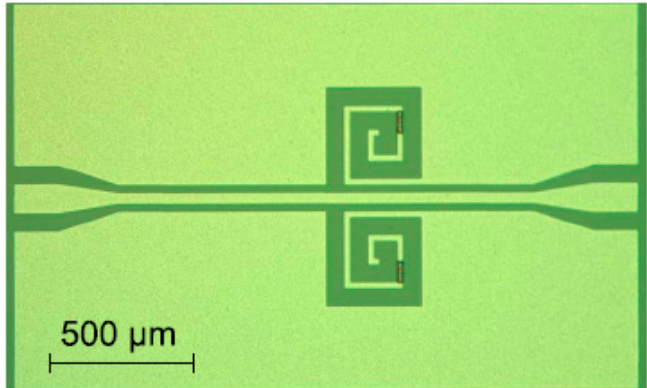
Figure 3. A photo of the reconfigurable microstrip filter [40].